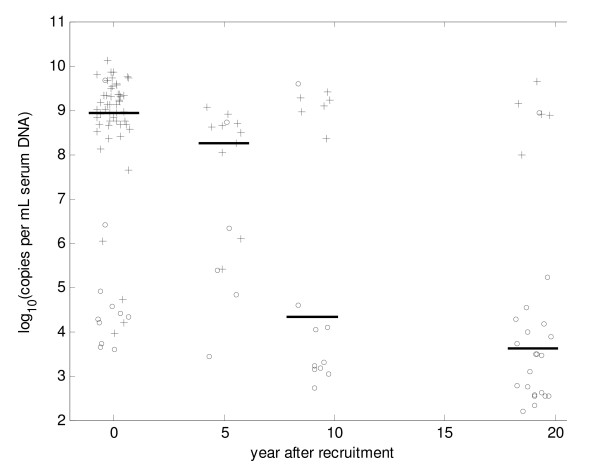
Change in serum HBV DNA with time in HBsAg carriers detected between 1–4 years of age. Horizontal bars represent median values. HBeAg positive carriers are represented by crosses and HBsAg negative carriers by the open circles.